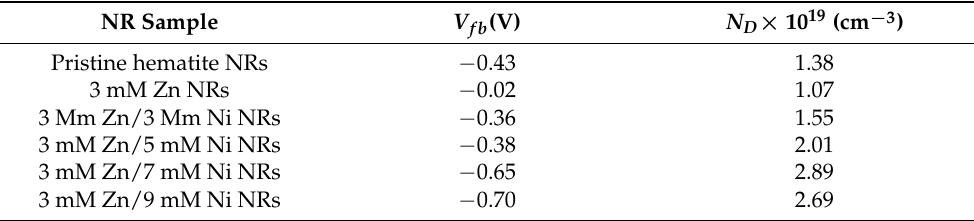
Table 2. Flat band potential ( V fb )/V and donor densities N D × 10 19 /cm − 3 of pristine and doped hematite NR samples synthesized over hematite seed layers.